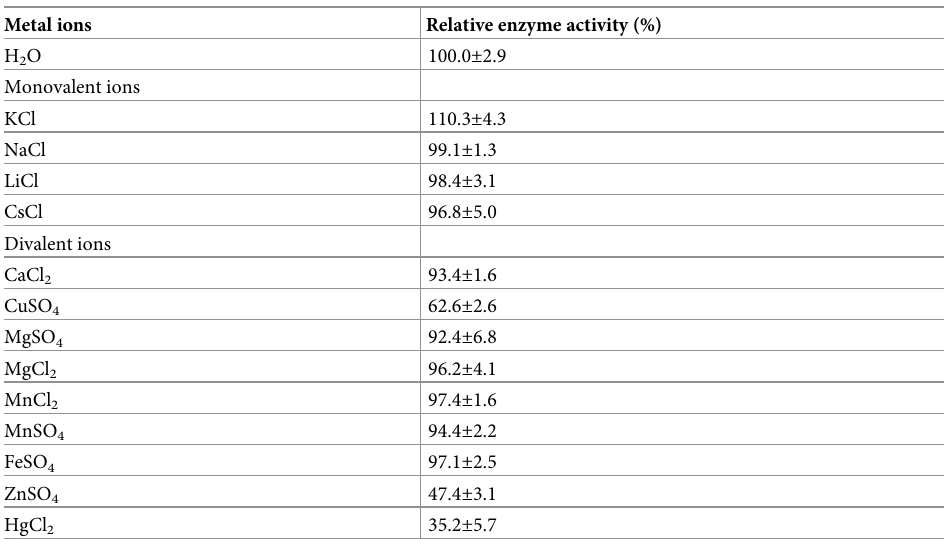
Table 1. Effect of metal ions on AglB activity.